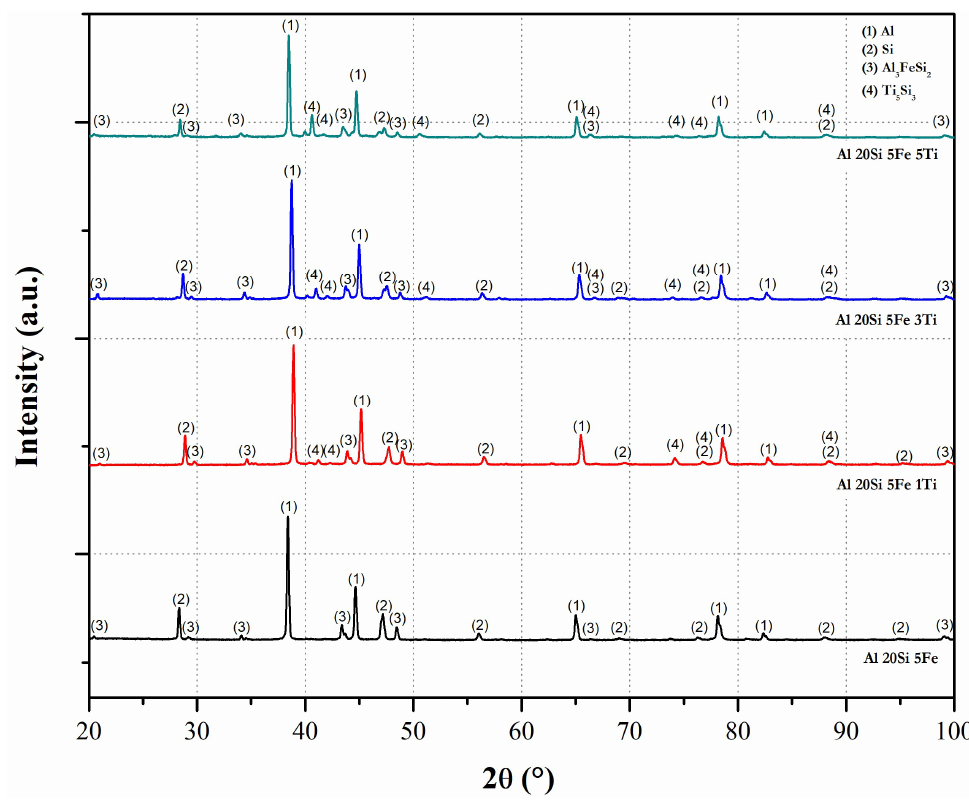
Figure 7. X-ray diffraction pattern of the Al–20Si–5Fe masters alloy and the Ti additions.